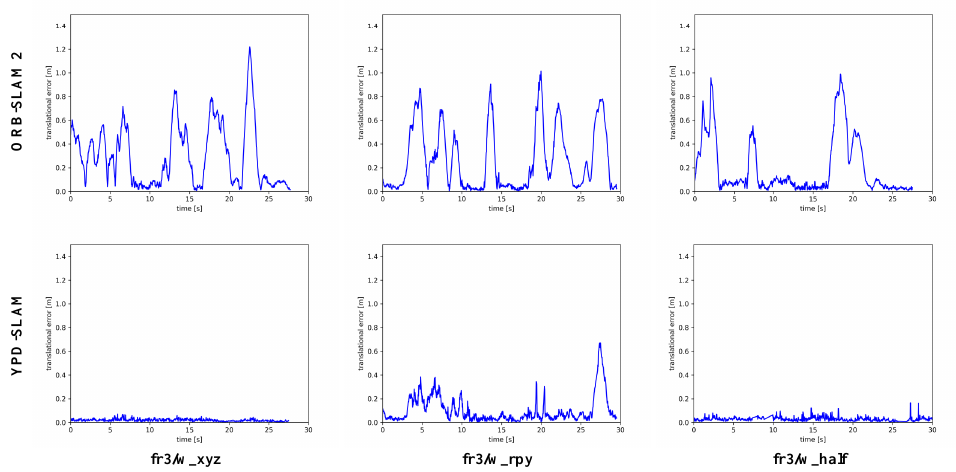
Figure 10. The RPE results of ORB-SLAM2 and YPD-SLAM in fr3/w_xyz, w_rpy, and